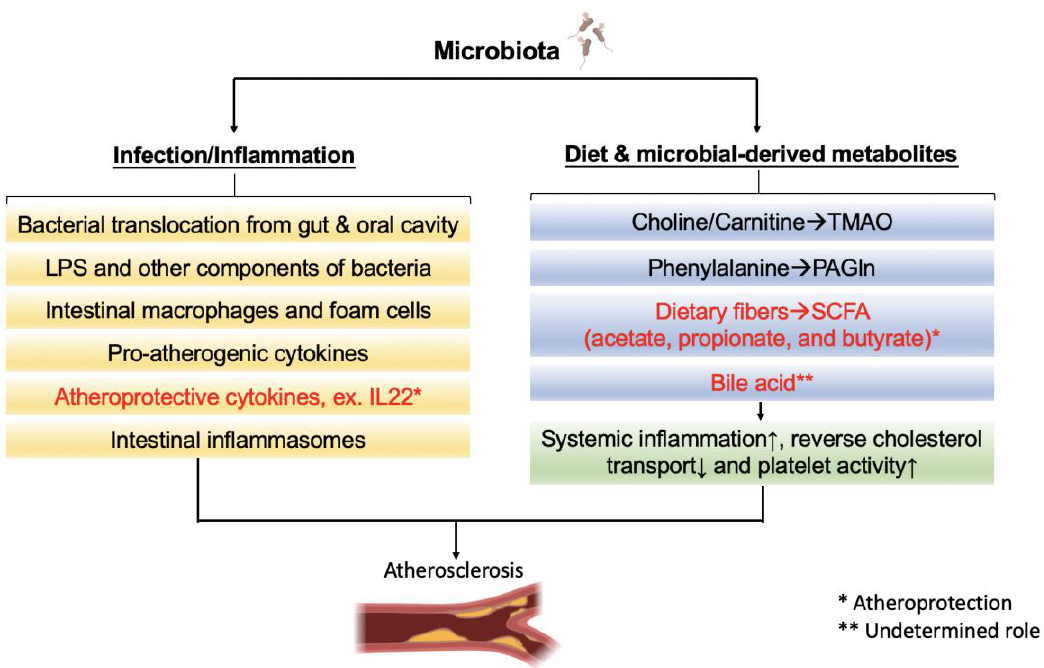
Figure 1. Microbiota-related pathways in atherosclerosis.